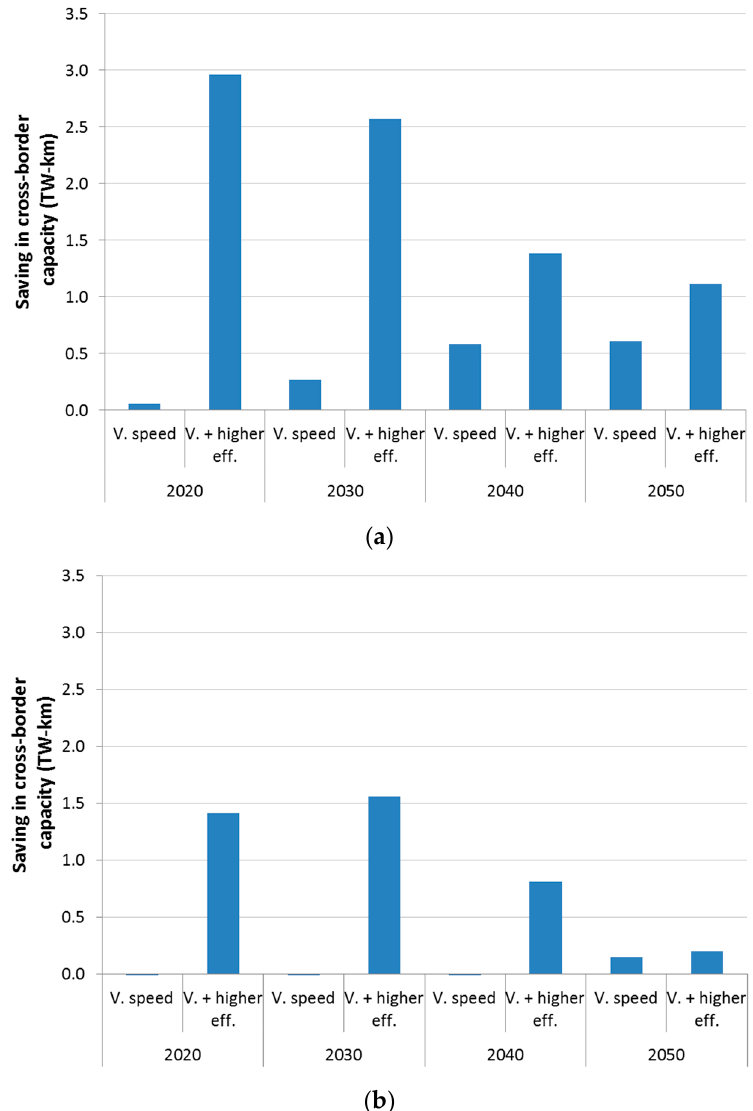
Figure 7. Impact of deploying variable-speed PSPs on the European main transmission network. ( a ) Low RES scenario; ( b ) High RES scenario.